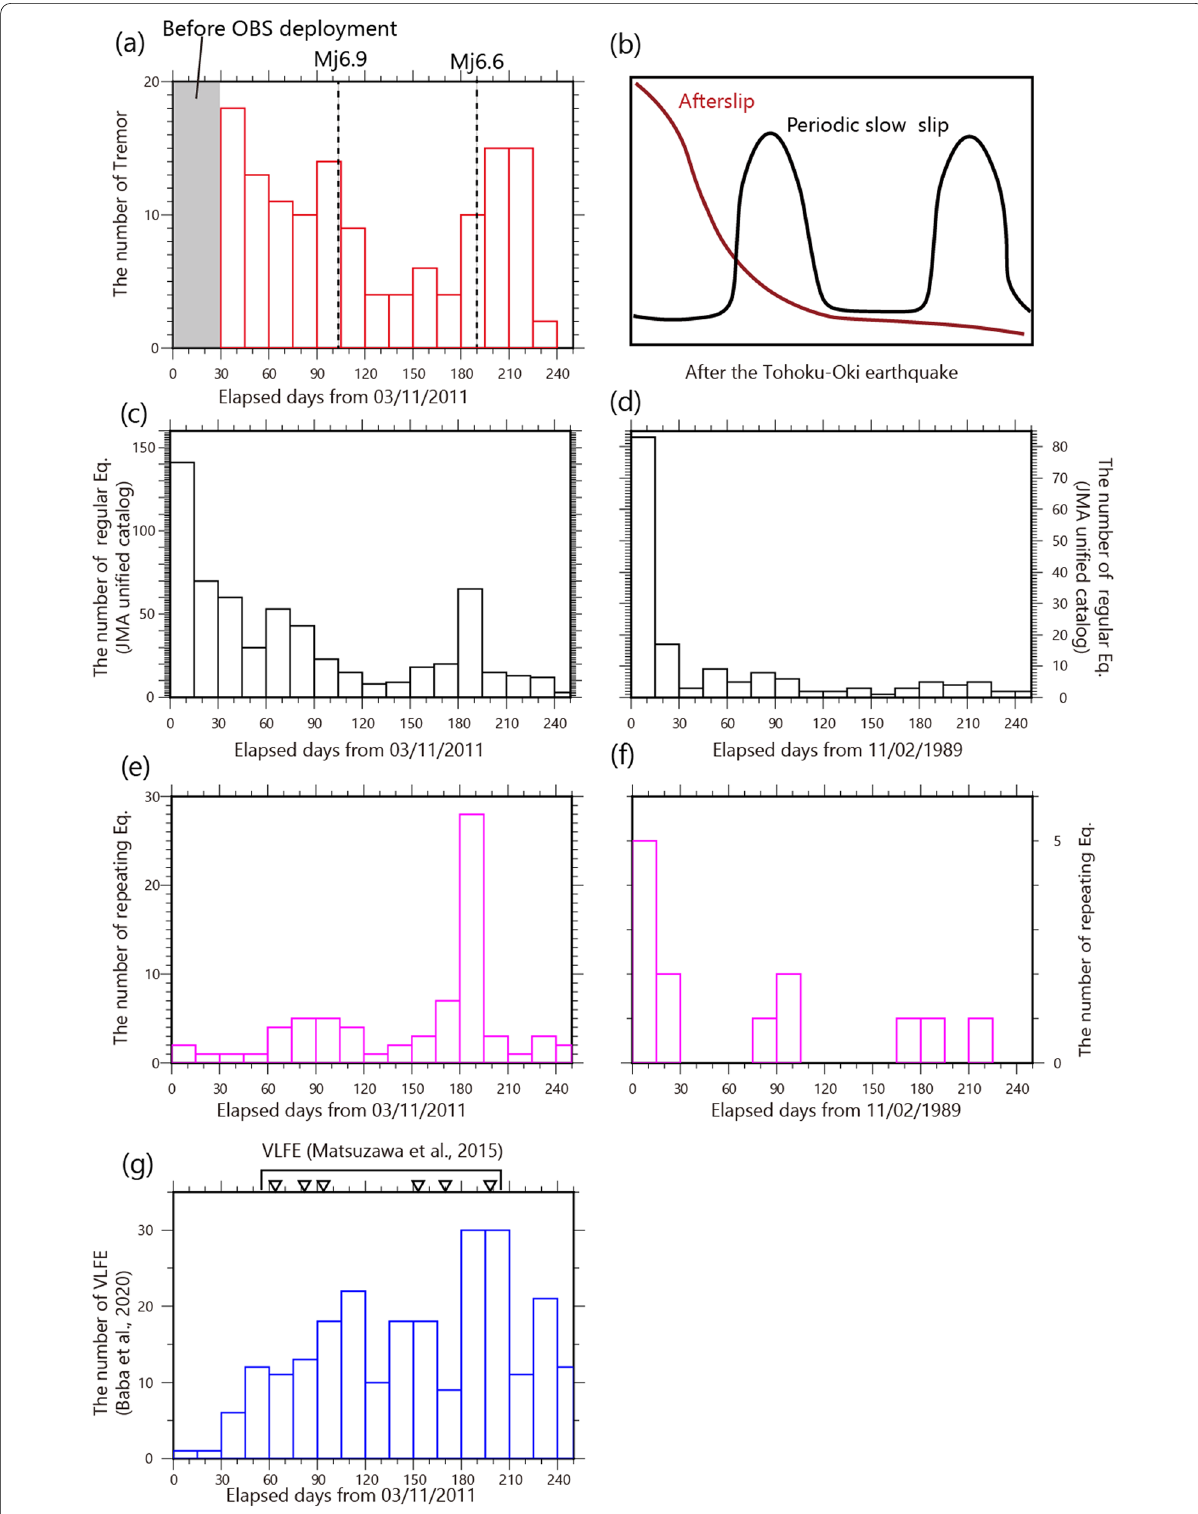
Fig. 11 (See legend on previous